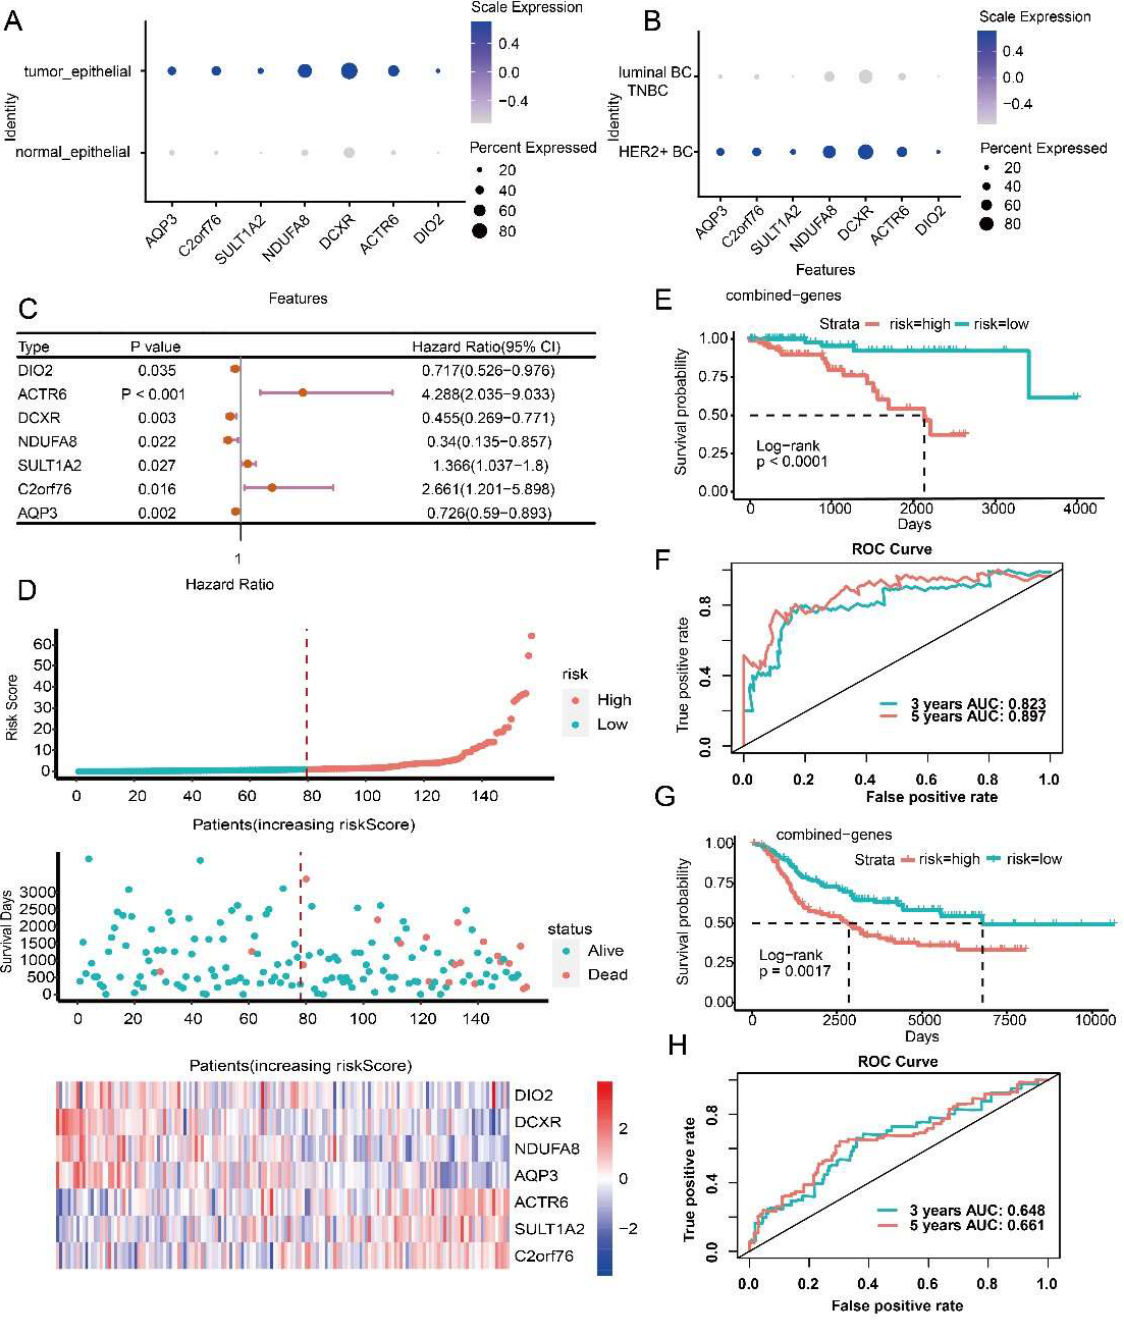
Figure 6. Construction and evaluation of the prognostic risk model for HER2+ BC. ( A ) Expression levels of prognostic factors between normal and cancer cells. ( B ) Expression levels of prognostic factors in cancer cells of HER2+ BC and other subtypes. ( C ) HR and p values of prognostic factors by univariate Cox regression. ( D ) Risk curves and scatter plots of sample survival probability for each sample reordered by risk score, heatmap of expression of prognostic factors in low-risk and high-risk groups. ( E ) Differences in overall survival between high-risk and low-risk groups in the training cohort of HER2+ BC. ( F ) Receiver operating characteristic curve (ROC) analysis of the sensitivity and specificity of the prognostic model in the training cohort of HER2+ BC. ( G ) Differences in overall survival between high-risk and low-risk groups in the external validation cohort of HER2+ BC. ( H ) ROC analysis of the sensitivity and specificity of the prognostic model in the external validation cohort of HER2+ BC.